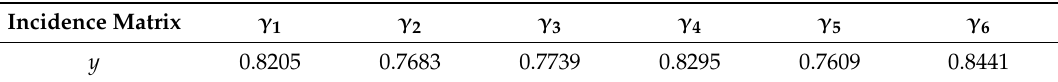
Table 8. Grey relational degree matrix of influential factors on subsurface runo ff